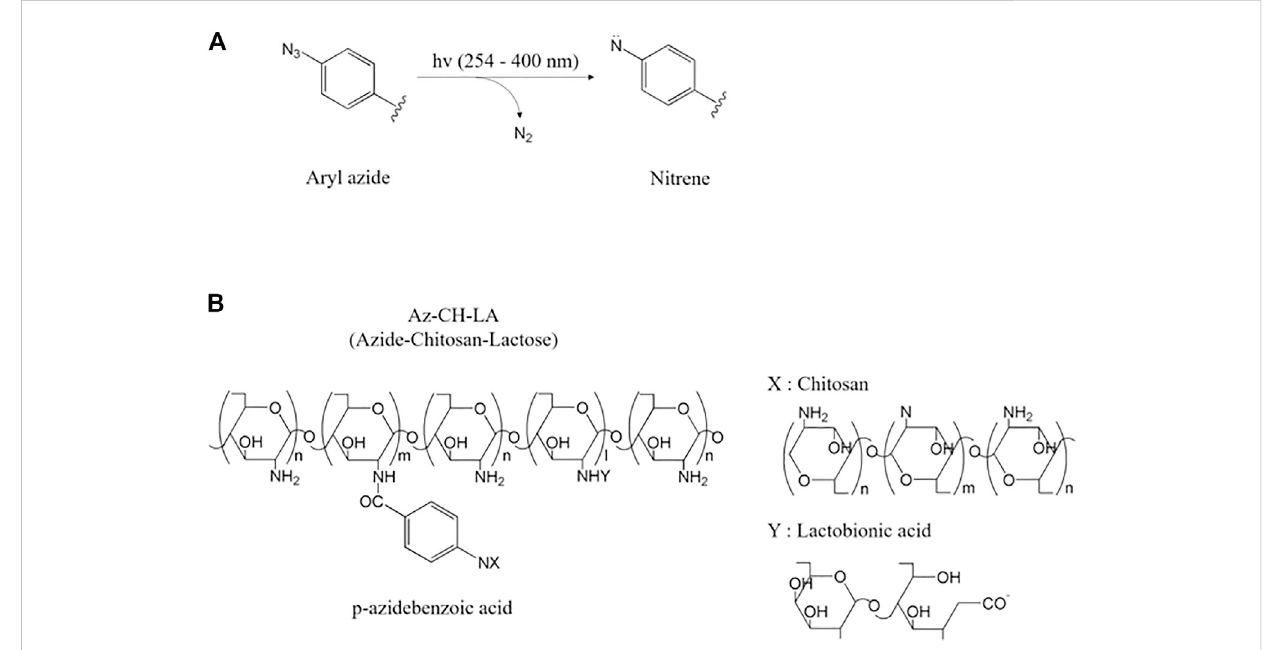
FIGURE 7 (A) Arylazidemoiety isconverted intohighly reactivenitrenebyreleasing N ₂ underUVlight(Tanakaetal.,2008)and (B) azide-chitosan-lactose